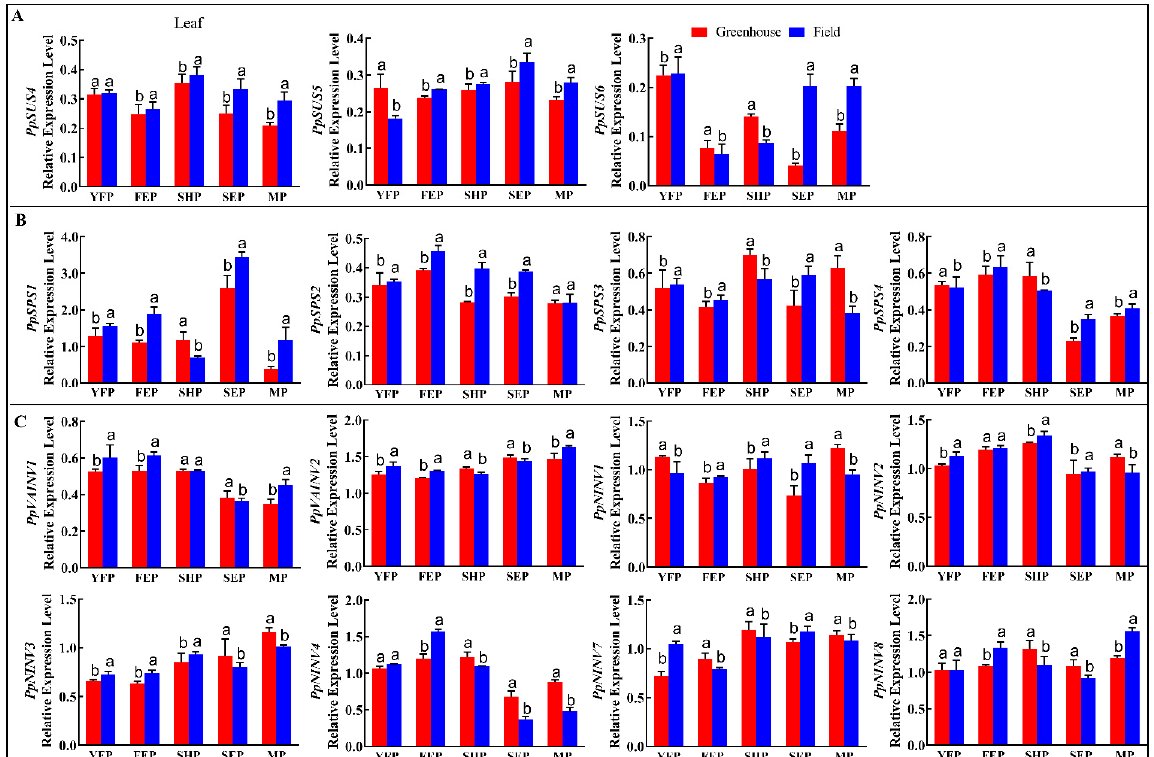
Figure 7. Expression levels of sucrose metabolism-related genes in leaves of plants grown in field and greenhouse environments. ( A – C ) show the expression levels of SUS, SPS and INV-related genes, respectively. The data are presented as the means ± SDs from three biological replicates. Different lowercase letters indicate significant differences ( p < 0.05).